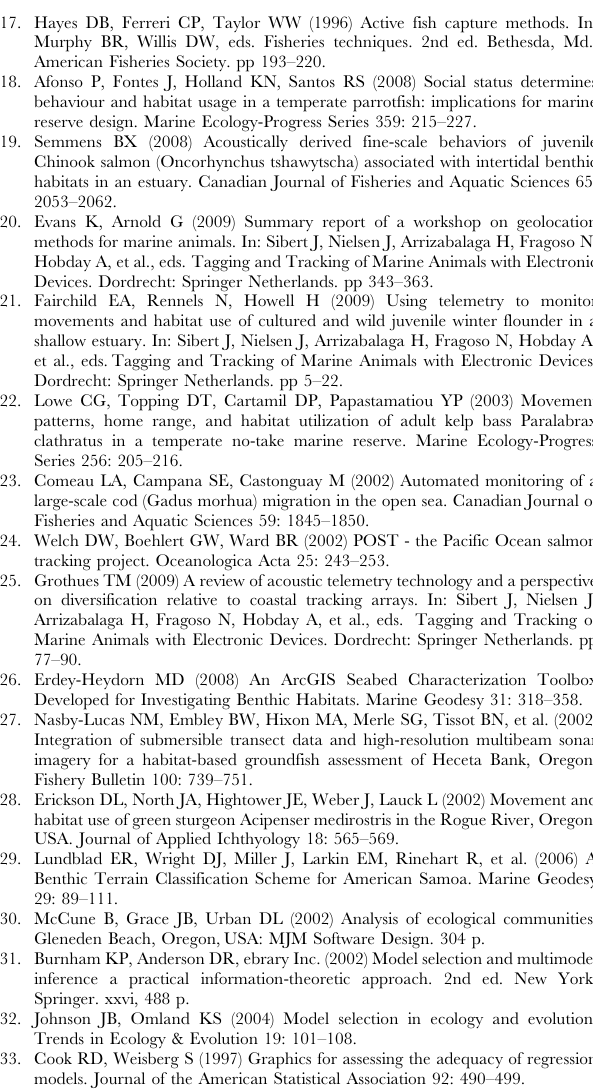
Figure S1 Temperature (top panel) and depth (bottom